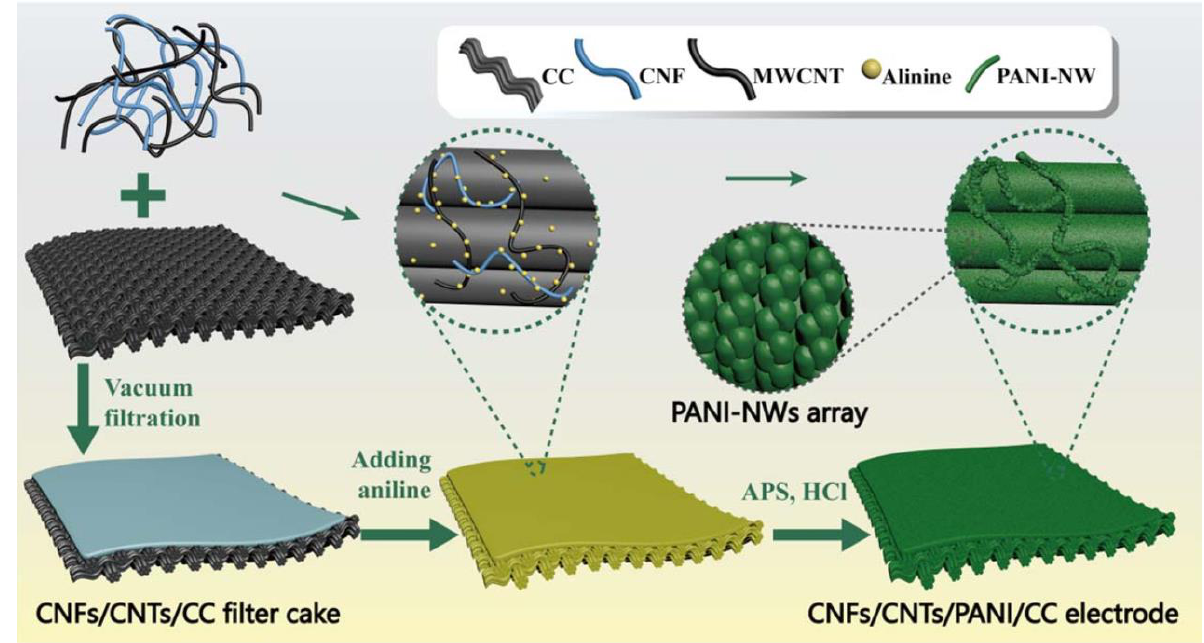
Figure 9. Schematic of the preparation process of CNFs/CNTs/PANI-NW/CC electrodes. Reprinted with permission from ref. [152]. 2018 IOP Publications.